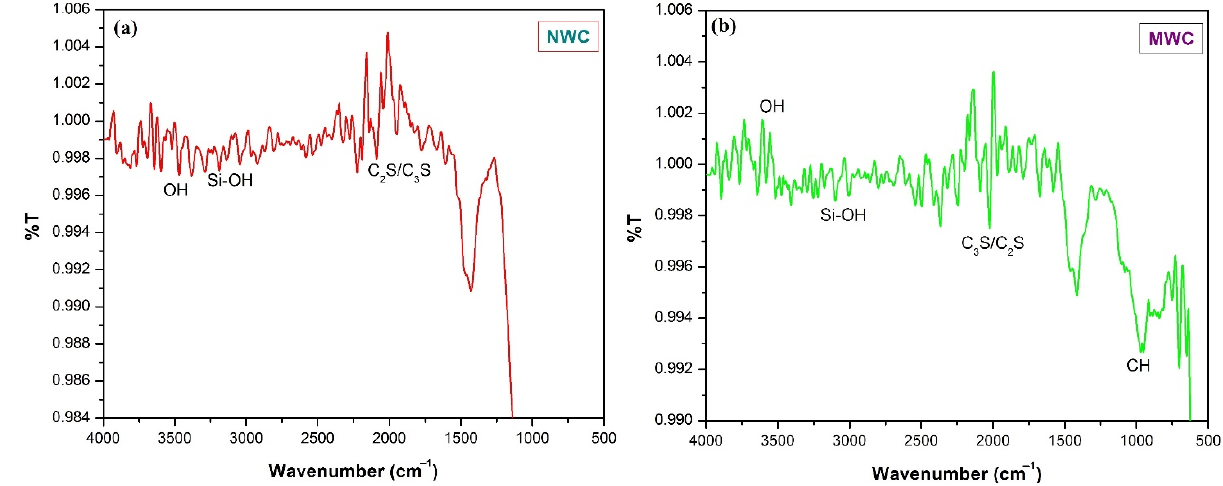
Figure 11. FTIR spectrum of concrete specimens prepared with ( a ) NWC and ( b )